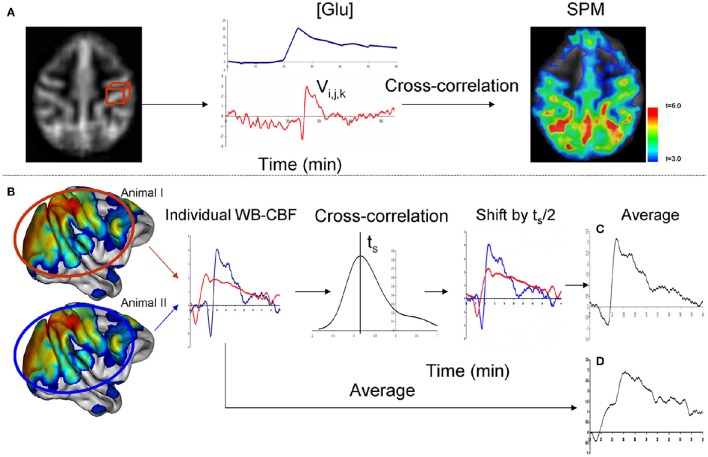
Data analysis was performed in two steps. During the first step (A), cerebral area with CBF trends that followed the trends of blood glucose levels ([Glc]) were identified using cross-correlation analysis. During the second step (B), time-shift analysis was performed to calculate the average, across all significant voxels, wave-form and the time of onset for individual animals. Cross-correlation is used to calculate the time (ts) which maximizes the correlation-coefficient between the CBF trends among the individual animals. Correction for individual differences in times provided for a clarified average CBF trend when compared to a simple averaging (C,D).